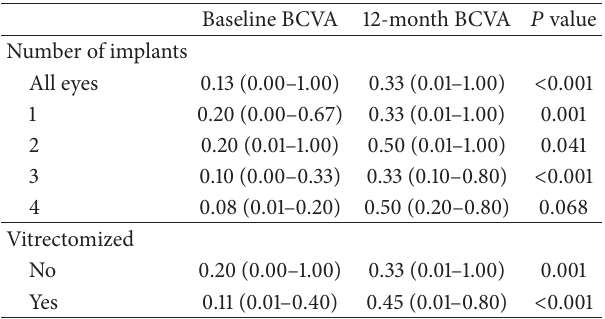
Table 4: Baseline and 12-month BCVA related to the numbers of implants and